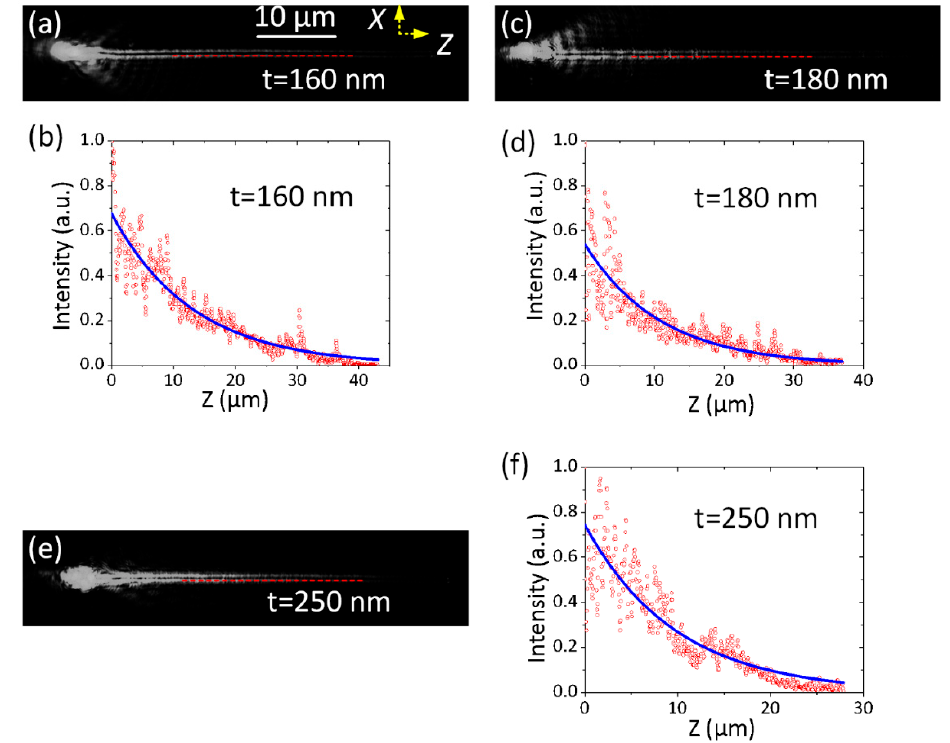
Figure 5. FFP images of the plasmon’s propagations. Three Ag NWs of the same diameter (about 70 nm) were put on three substrates with different thickness of the top SiO 2 layer. The top SiO 2 layer’s thickness was ( a , b ) t = 160 nm; ( c , d ) t = 180 nm, and ( e , f ) t = 250 nm, respectively. The incident wavelength was selected as 590 nm. On ( b , d , f ), the blue solid line is an exponential fit to the data (red dots) and was used to extract the propagation distance of the plasmonic mode as 13 μ m (at t = 160 nm), 11 μ m (at t = 180 nm), and 10 μ m (at t = 250 nm). The scale bar in ( a ) is also applicable for ( c , e ).